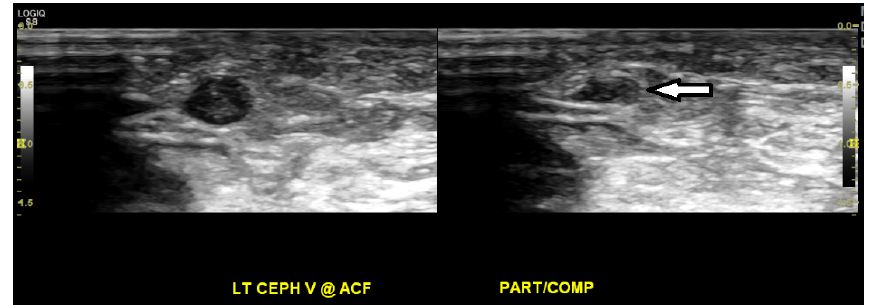
Figure 3. Ultrasound venous duplex imaging of the bilateral upper extremities shows echogenic, non-compressible material in the left cephalic vein, representing acute, non-occlusive thrombosis (white arrow), and also in the right cephalic vein in the distal arm (not shown).